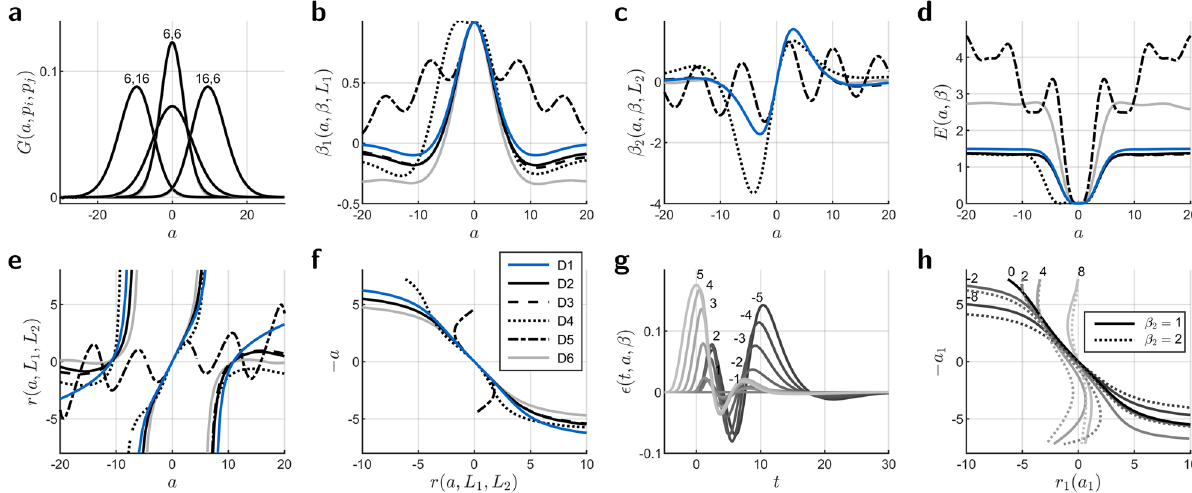
Figure 1. Shift dependencies for parameters of HRF decomposition. Shift a is in seconds. Residual functions ǫ( t , a , β) and residual power E ( a , β) (A1) are in arbitrary units. ( a ) Components G ( a , p i , p j ) (5) for combination 16 . All components p j (A36) into k 1 ( a ) (4). Numbers indicate shape parameters p i and p j . When omitted, p i = = have practically identical least-squares approximations by single Gaussians or Gamma PDFs, ( b ) HRF coefficient β 1 ( a , β , L 1 ) (A6), ( c ) Derivative coefficient β 2 ( a , β , L 2 ) (A7), ( d ) Residual power E ( a , β) (A1), ( e ) Coefficient a ( r , L 1 , L 2 ) from r ( a , L 1 , L 2 ) by interchange of axes ratio r ( a , L 1 , L 2 ) (6), ( f ) Central ratio–latency function − 1 , ( g ) Examples of residual functions. Numbers indicate shift 1 and L 1 L 2 and interpolation, all for β = = = 1 in the presence of another a 1 ( r 1 , L 1 , L 2 ) for condition m in seconds, ( h ) Central ratio–latency functions = − 2 . Here, β m is the magnitude in condition m , β 1 1 . Numbers on curves indicate a 2 in seconds. condition m = = 2 is 8 s later in time. The legend in panel Both conditions contain only one HRF. The HRF of condition m = ( f ) applies to panels ( b – f ). D1–D6 are different versions of decomposition (1). D1, Omission of the constant regressor, D2, Decomposition as is, D3, Regressors and input filtered with SPM highpass filter at 128 s cutoff time (curves mostly overlap with D2), D4, Additional correlated regressor (the non-orthogonalized dispersion derivative), D5, Regressors with 5 HRFs or derivatives 8 s apart. Latency can be retrieved within ±2 s, D6, Regressors with 15 HRFs or derivatives about 32 s apart, filtering as in D3. The curves for D3, D4, and D6 are asymmetric. The latency range for D6 is [−5.51, 5.50], smaller than for D3 because of the multiple HRFs. All curves except D1 and D2 were power adds onto stochastic residual power (A16–A17) and via residual variance (A18) leads to over-estimated parameter variance. Despite the different shapes of residual functions for the same amount of shift to earlier and later time, residual power is symmetrical with respect to zero shift. Higher-order derivatives or time-shifted regressors reduce ǫ( t , a , β) and E ( a , β) , but even an infinite number of derivatives would not accomplish shift to earlier time, supplementary Fig. S1. Fortunately, there is no need for a residual function to vanish, if there is a means to retrieve latency from the coefficients to HRF and time derivative. Magnitude can then be estimated in a model without a time derivative, when the HRF regressor is shifted by the retrieved latency. Such a means is the former coefficient ratio–latency curve 15 , now with an assignment to the known initial shift as in Liao et al. 23 . That function a ( r , L 1 , L 2 ) , Fig. 1f, is the part of the ratio function